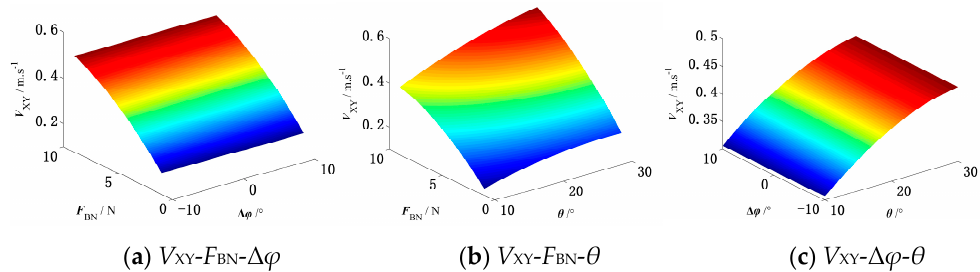
Figure 8. Approximate model of horizontal velocity.